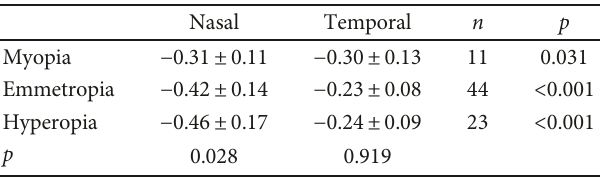
Table 3: The Q values of the anterior cornea of the children ’ s